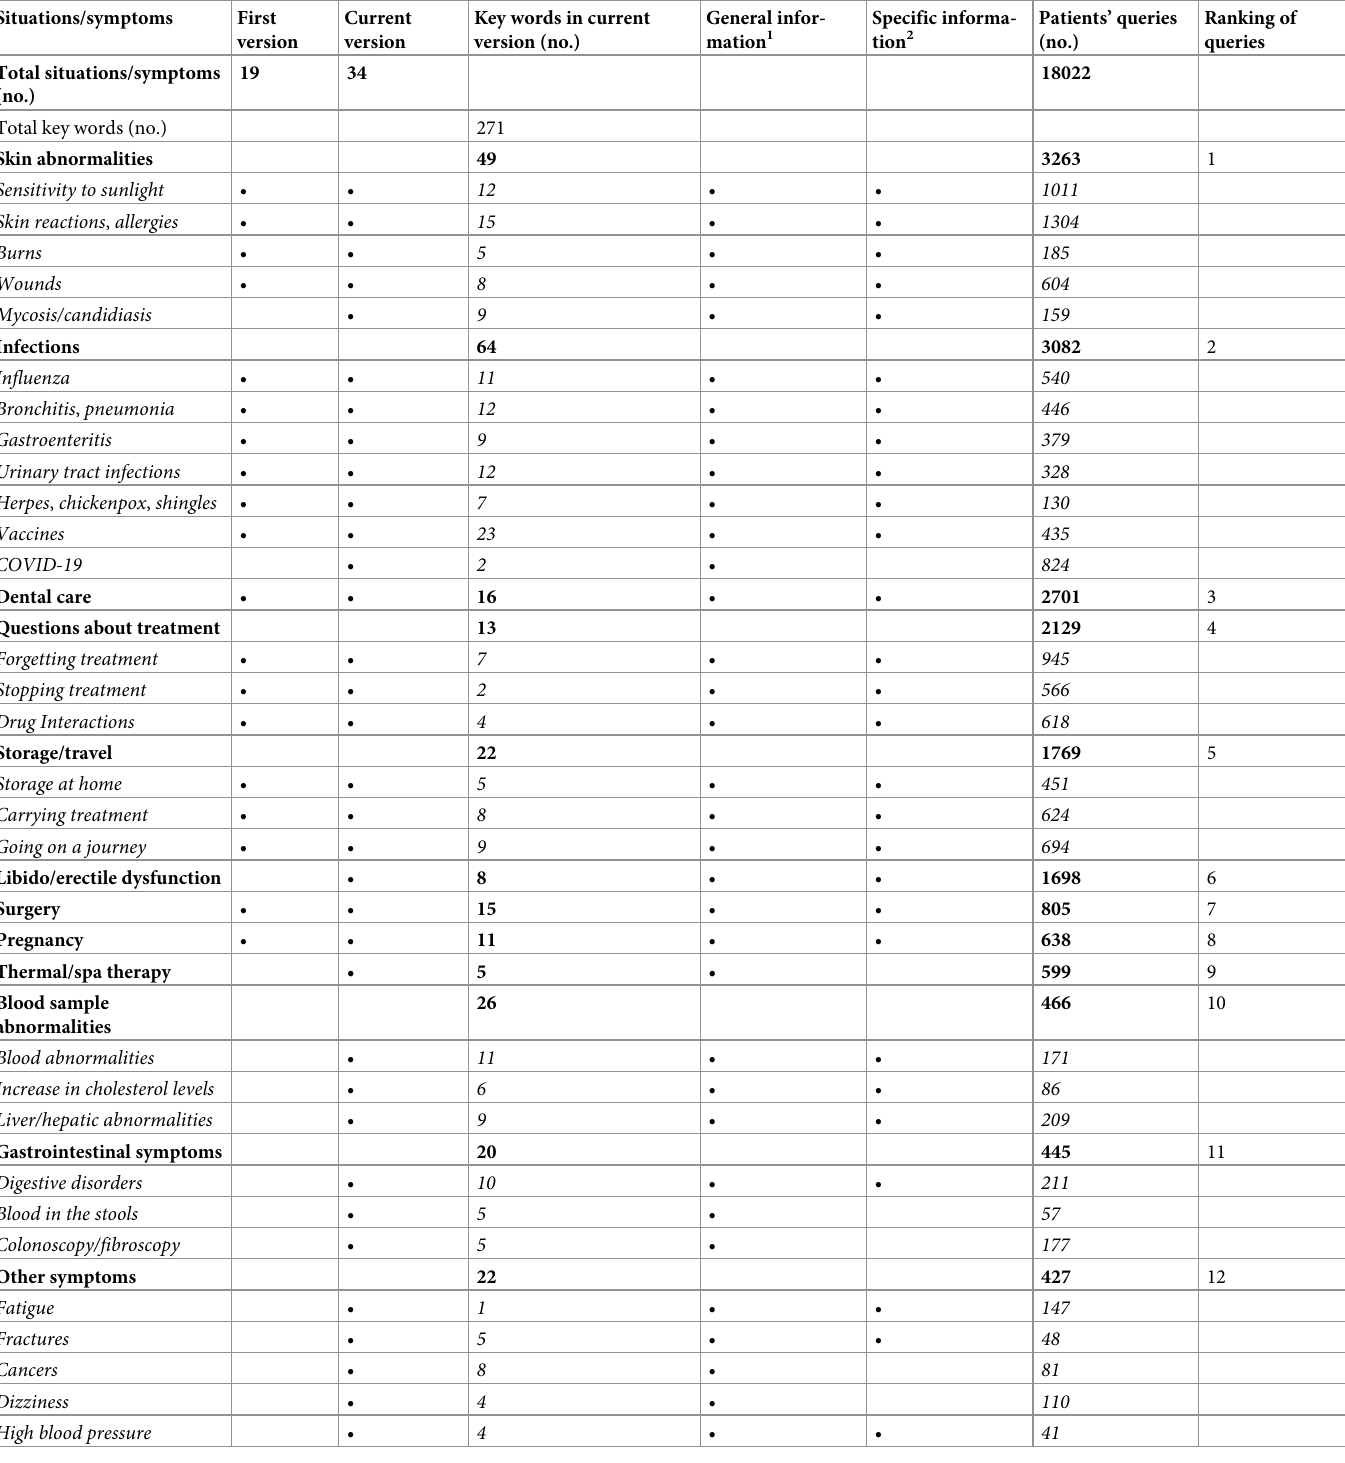
Table 4. Information on daily situations/symptoms and patient queries from the app from March to November 2020. Data collected in Google analytics.